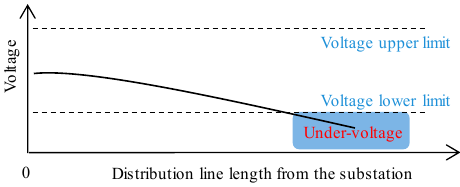
Figure 3. Diagram of an under-voltage profile.